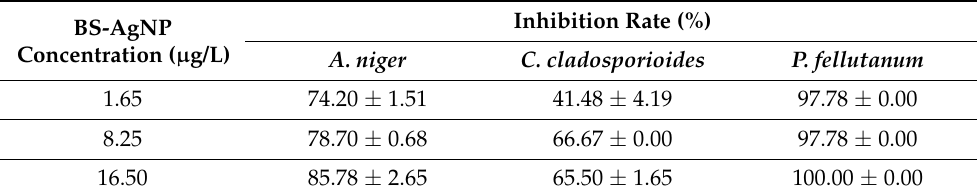
Table 1. Inhibition rate (%) caused by biosurfactant-complexed silver nanoparticles (BS-AgNPs) at different concentrations on Aspergillus niger , Cladosporium cladosporioides , and Penicillium fellutanum growth in potato dextrose agar (PDA) medium. Data expressed as the mean ± SD of triplicate determinations.